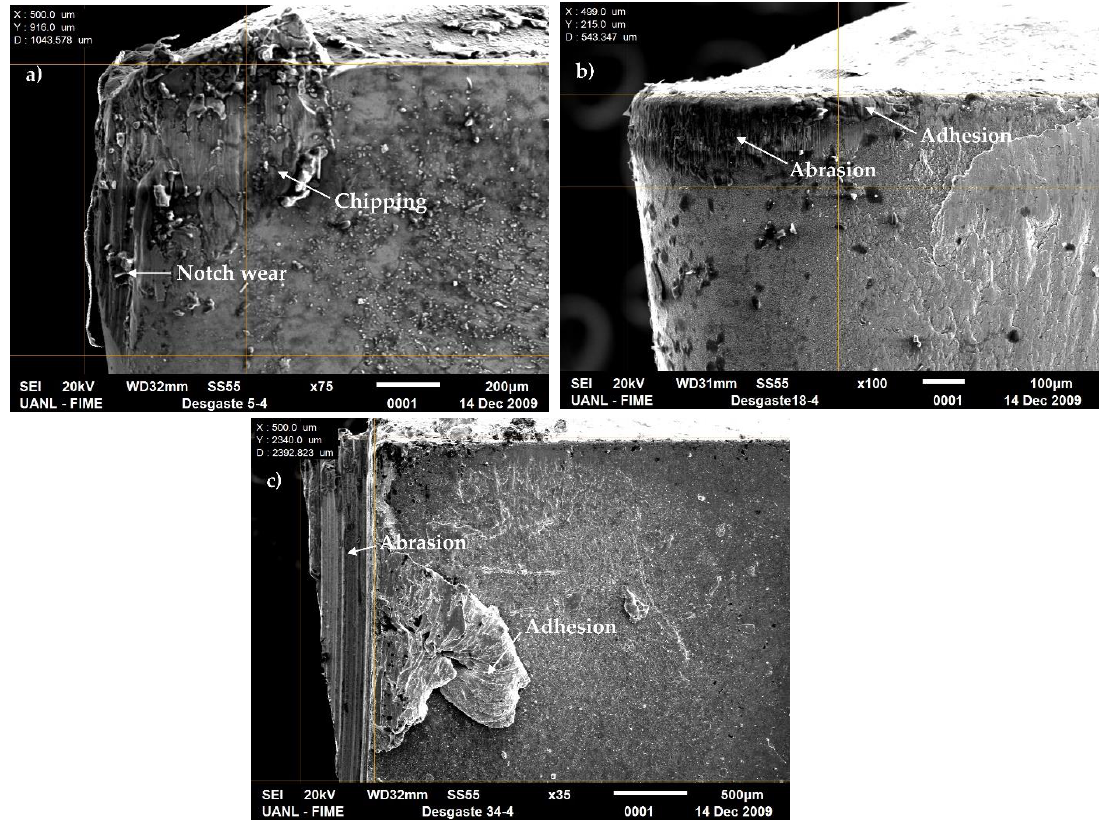
Figure 2. Flank wear for v = 600 m/min and T = 4 min, ( a ) for CT5015-P10 insert, ( b ) for GC4215-P15 insert and ( c ) for GC4225-P25 insert.